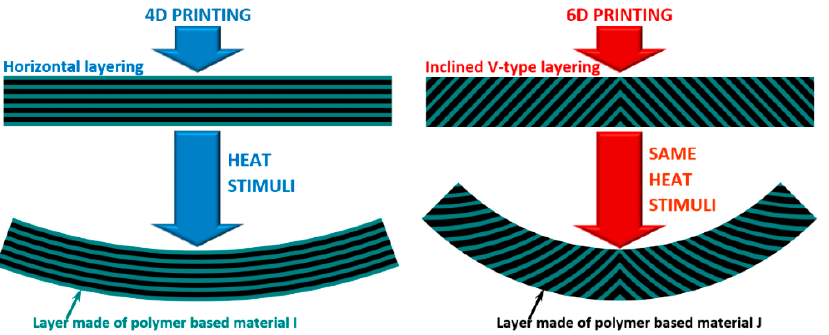
Figure 3. An indicative comparison between 4D and 6D printing: Bending deformation of a printed component is increased due to a heat stimulus when the proposed 6D printing process is utilized instead of the 4D one.